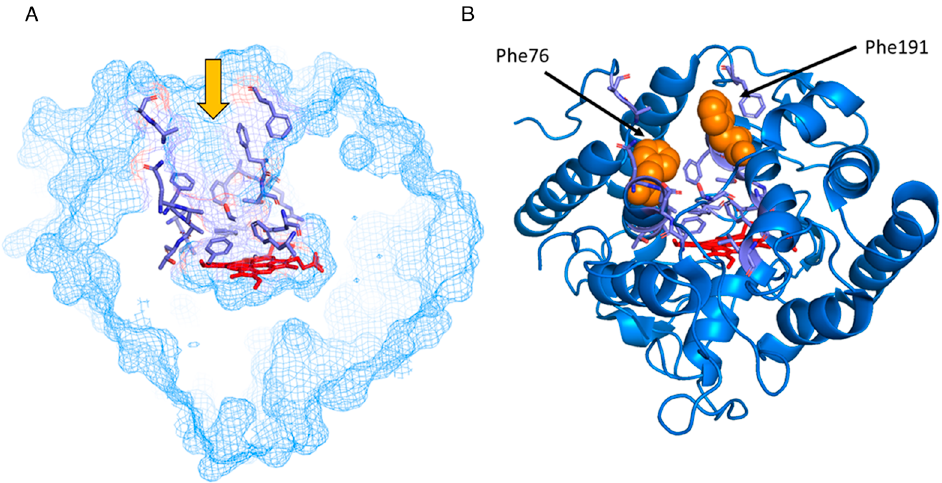
Figure 1. ( A ) Substrate access channel in PaDa-I model structure (PDB ID: 5OXU). The topography of the channel is delimited by the following residues (in violet): Phe69, Asp70, Gln72, Ala73, Phe76, Ala77, Thr78, Ala80, Ala81, Phe121, Phe188, Arg189, Phe191, Thr192, Glu196, Phe199, Leu203, Ser240, Phe274, Ala316, and Ala317. The orange arrow signals the entrance to the channel that ends in the heme pocket (heme group in red). ( B ) Residues Phe76 and Phe191 (light orange) in the substrate access channel were replaced with Ala or Leu in variants F76A, F191A, F76L, F76A/F191A, and F76L/F191A.